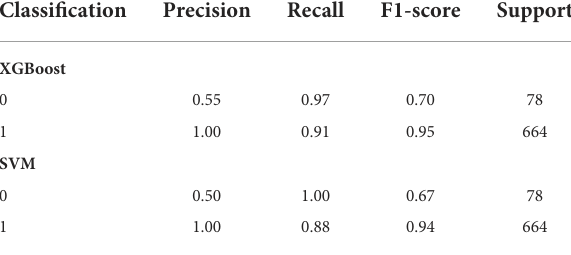
TABLE 4 Classification report for XGBoost and